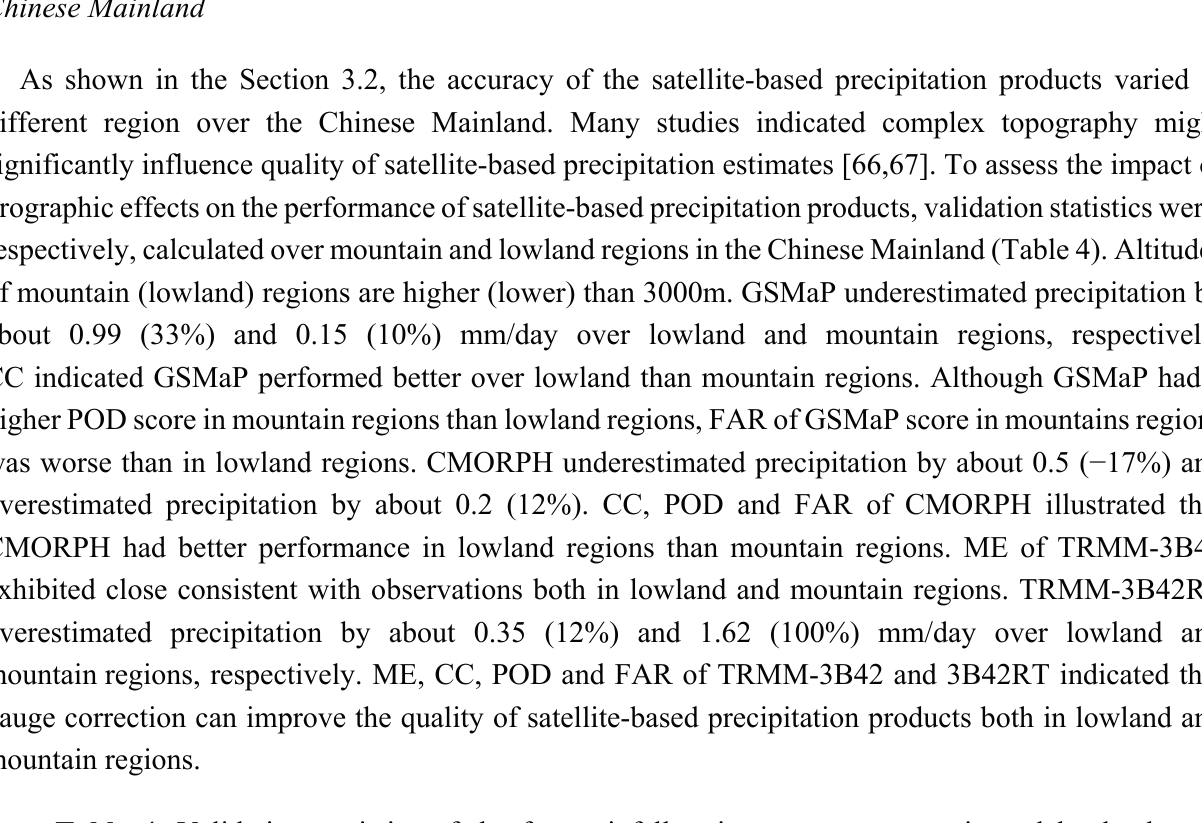
Table 4. Validation statistics of the four rainfall estimates over mountain and lowland regions in the Chinese Mainland from 2003 to